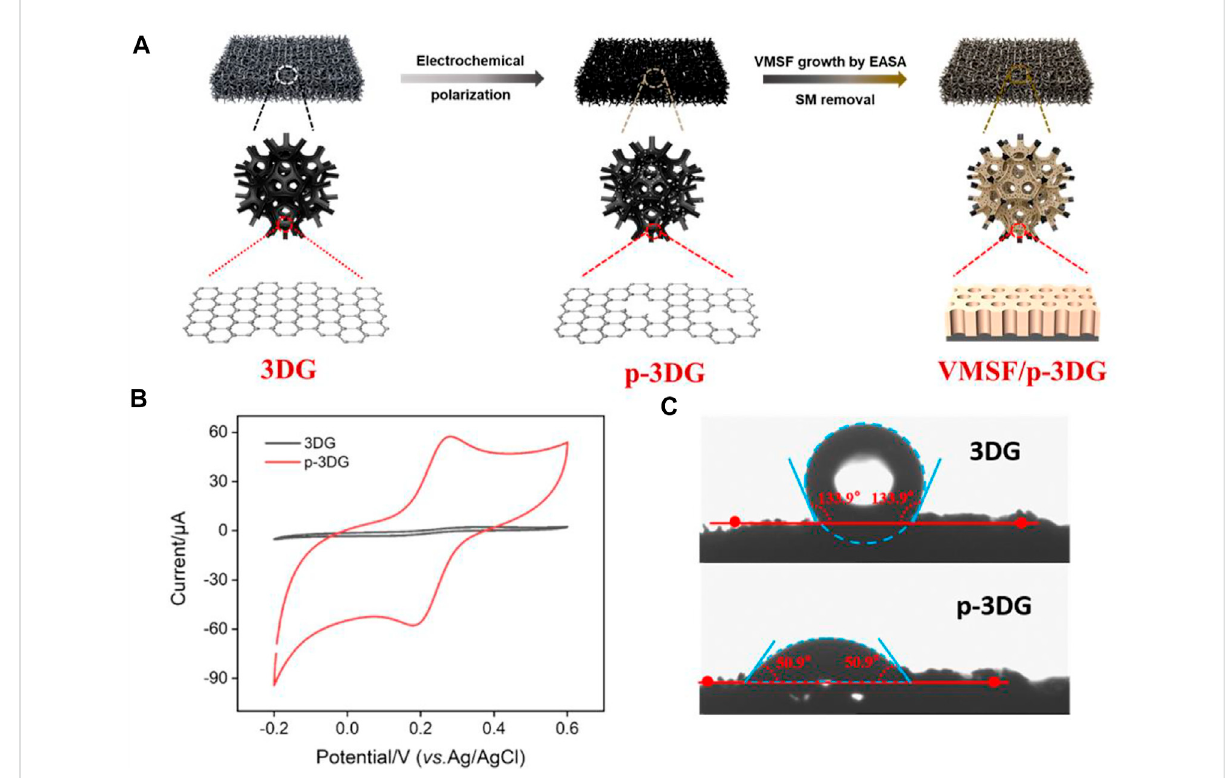
FIGURE 1 (A) Schematic illustration for the preparation of VMSF/p-3DG. (B) CV curves obtained at 3DG and p-3DG electrodes in Fe(CN) 6 3 − solution (0.5 mM) containing 0.1 M KCl. (C) Contact angle images of 3DG and